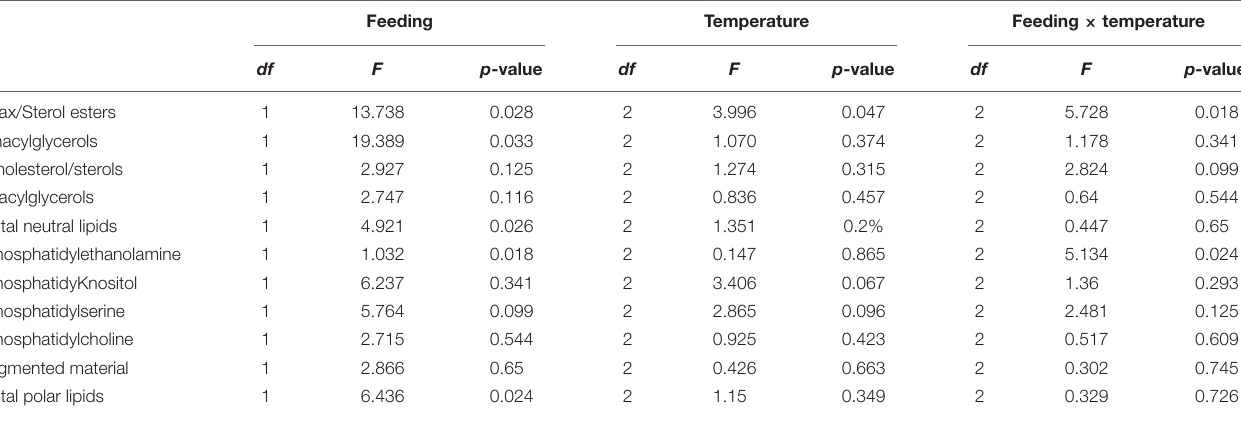
TABLE 5 | Two-factor ANOVA on lipid class analysis of lipid samples extracted from hepatopancreas tissue from H. gammarus fed and unfed kept at different holding temperatures (4, 8, 12 ◦ C) after being held in captivity for 24 weeks. Feeding